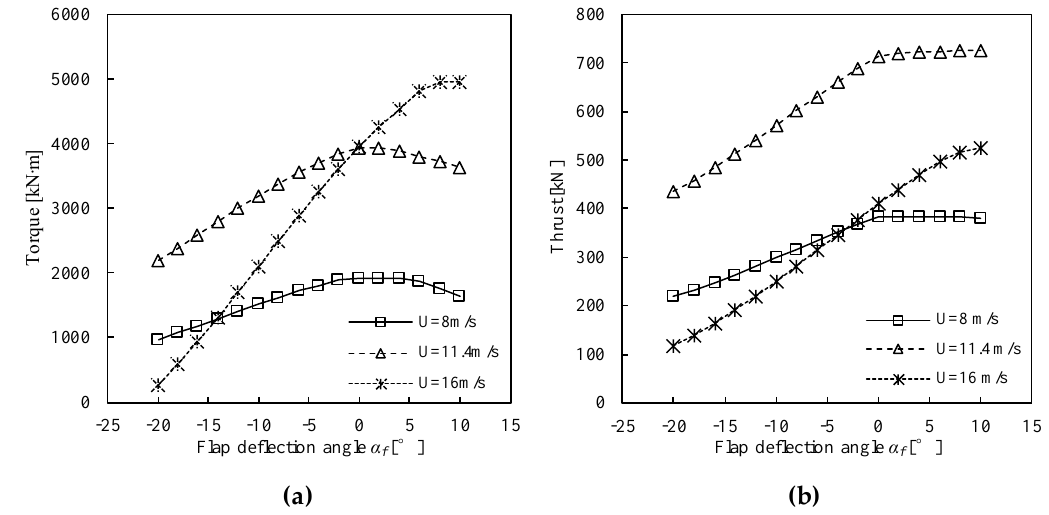
Figure 5. Effect of the trailing-edge flap deflection angle on the torque and thrust of the NREL 5-MW wind turbine rotor. ( a ) Low speed shaft torque, ( b ) Rotor thrust.